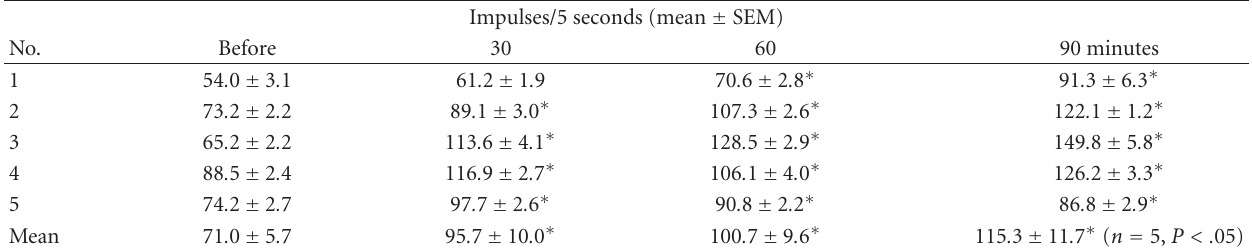
Table 1: Firing rate response of vagal hepatic a ff erent fibers before and after intraportal injection of leptin (100pg. 0.1